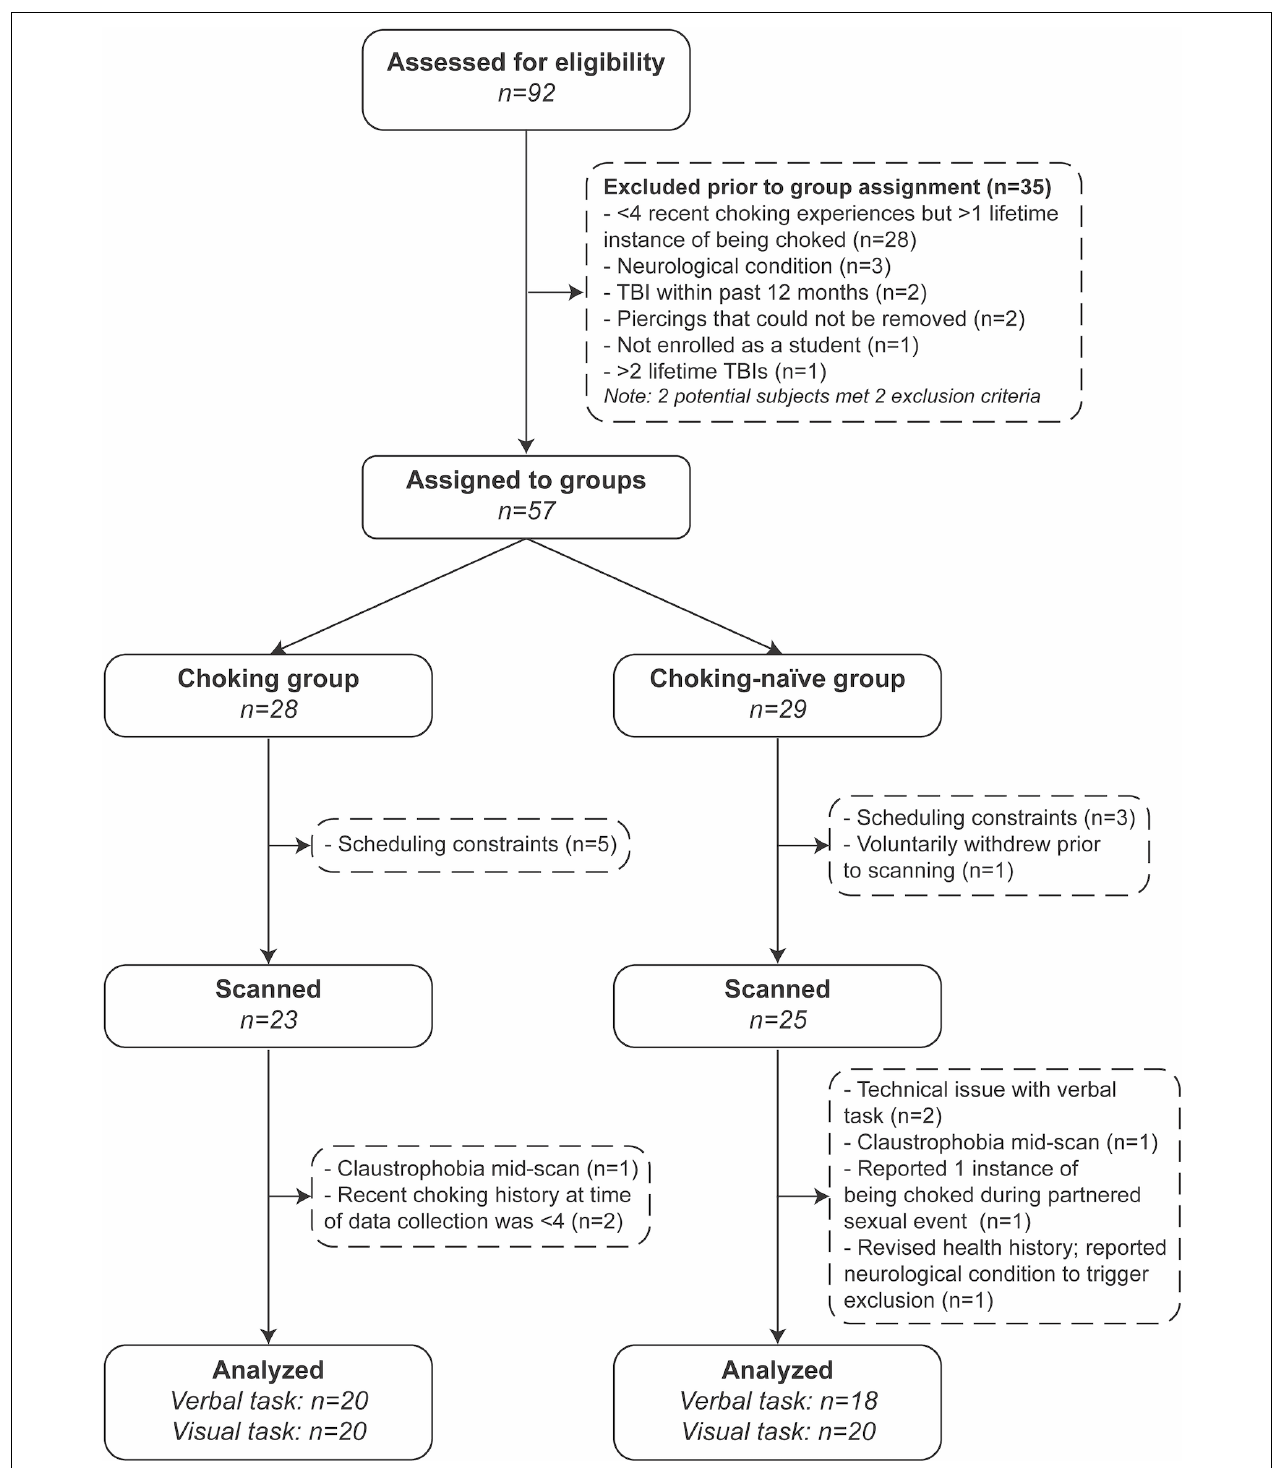
FIGURE 1 | Study flow